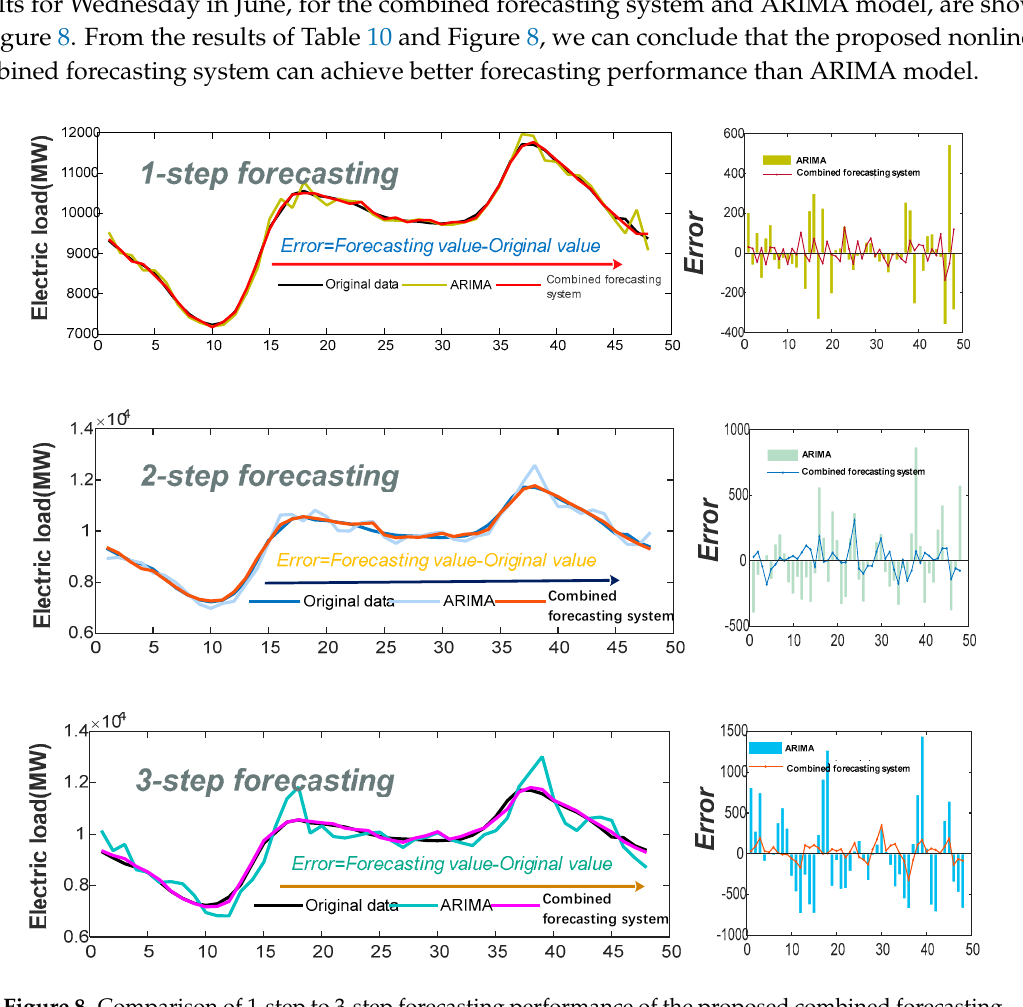
Figure 8. Comparison of 1-step to 3-step forecasting performance of the proposed combined forecasting system and ARIMA model.